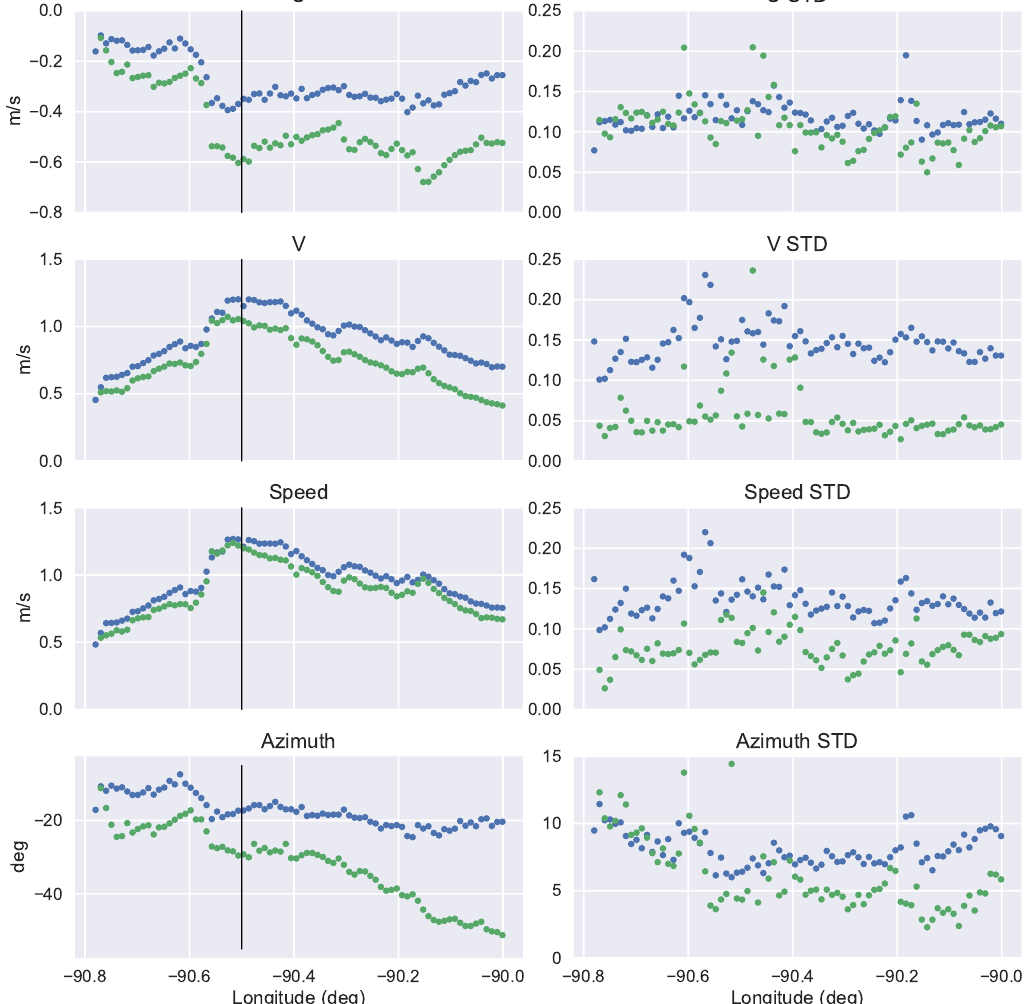
Figure 24. (right column) Parameter average over the 5km swath as a function of latitude for DopplerScatt (blue) and ROCIS (green). (right column) Standard deviation of the parameter for 1km longitude by 5km latitude bins. These standard deviations are estimates of the instrument noise, given that little variation in the current is expected over this size averaging cell. (top row) U component; (second row) V component; (third row) current speed; (bottom row) azimuth relative to north. Data for 25 March